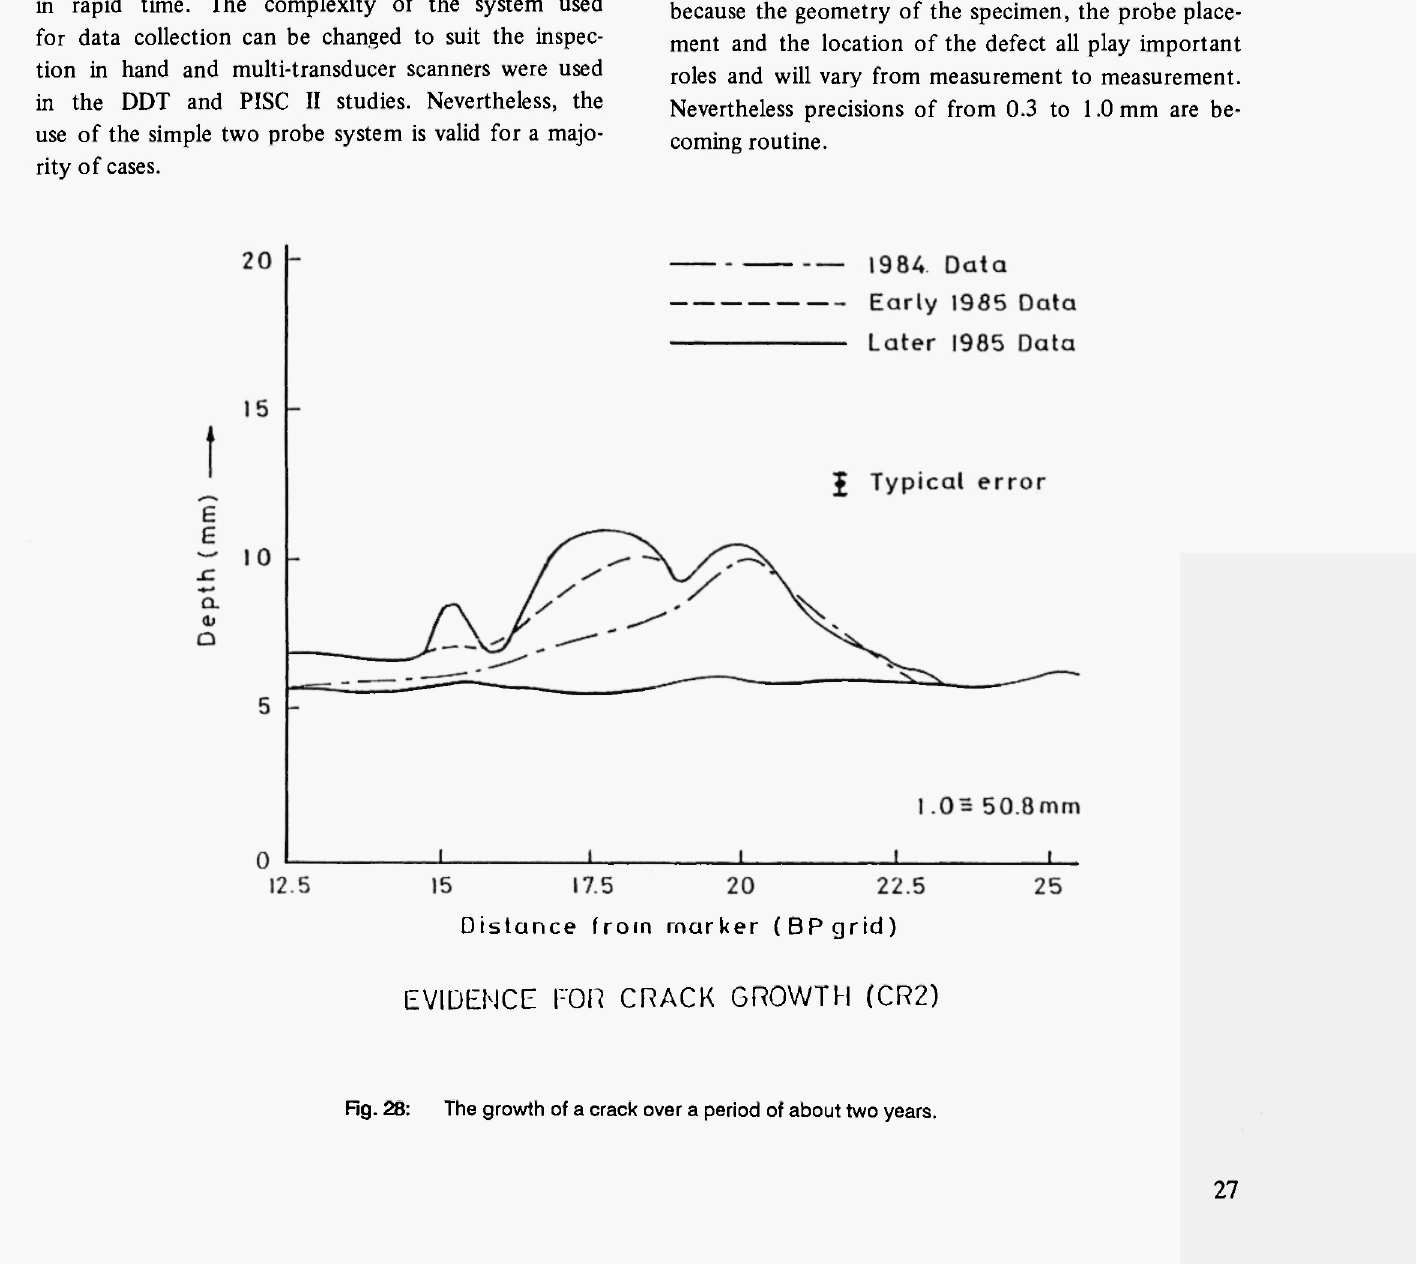
Fig. 28: The growth of a crack over a period of about two